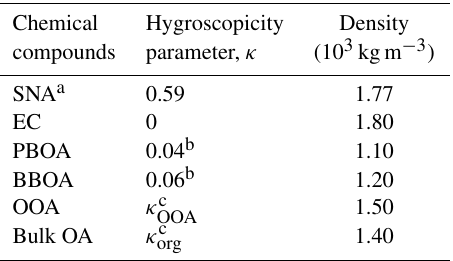
Table 1. Summary of the hygroscopicity parameters ( κ ) and mate- rial densities of different chemical constituents utilized in the theo- retical κ calculation with chemical data. Chemical Hygroscopicity Density compounds parameter, κ (10 3 kgm − 3